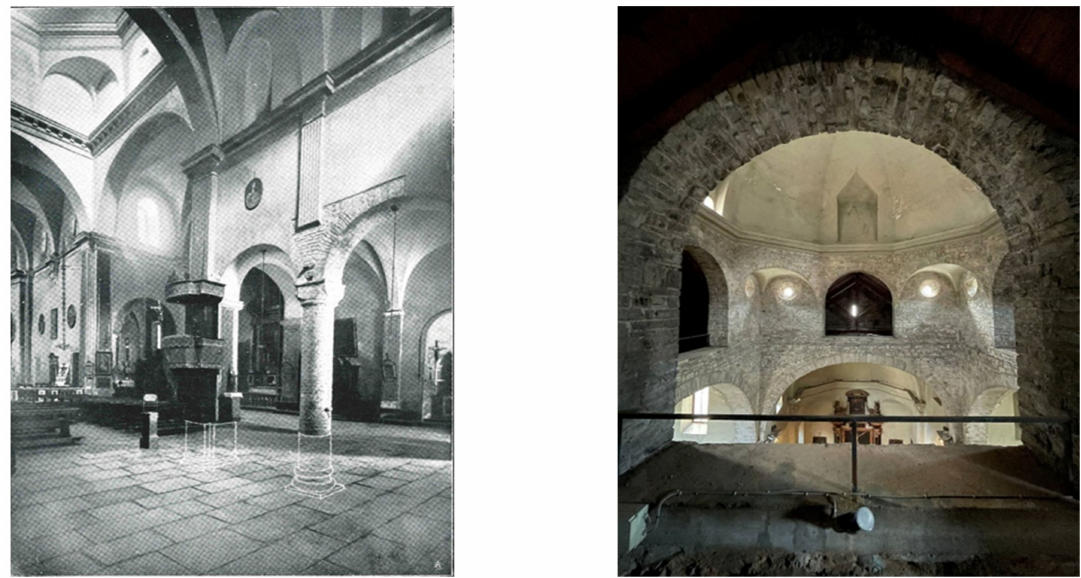
Figure 2. Left: The photo by F. Frigerio from the interior of San Giacomo in 1923, after restoration work, presents the removal of some layers and appearance of the Romanesque parts. Right: The situation after 1970 works, in a photo captured by C. Bernasconi in